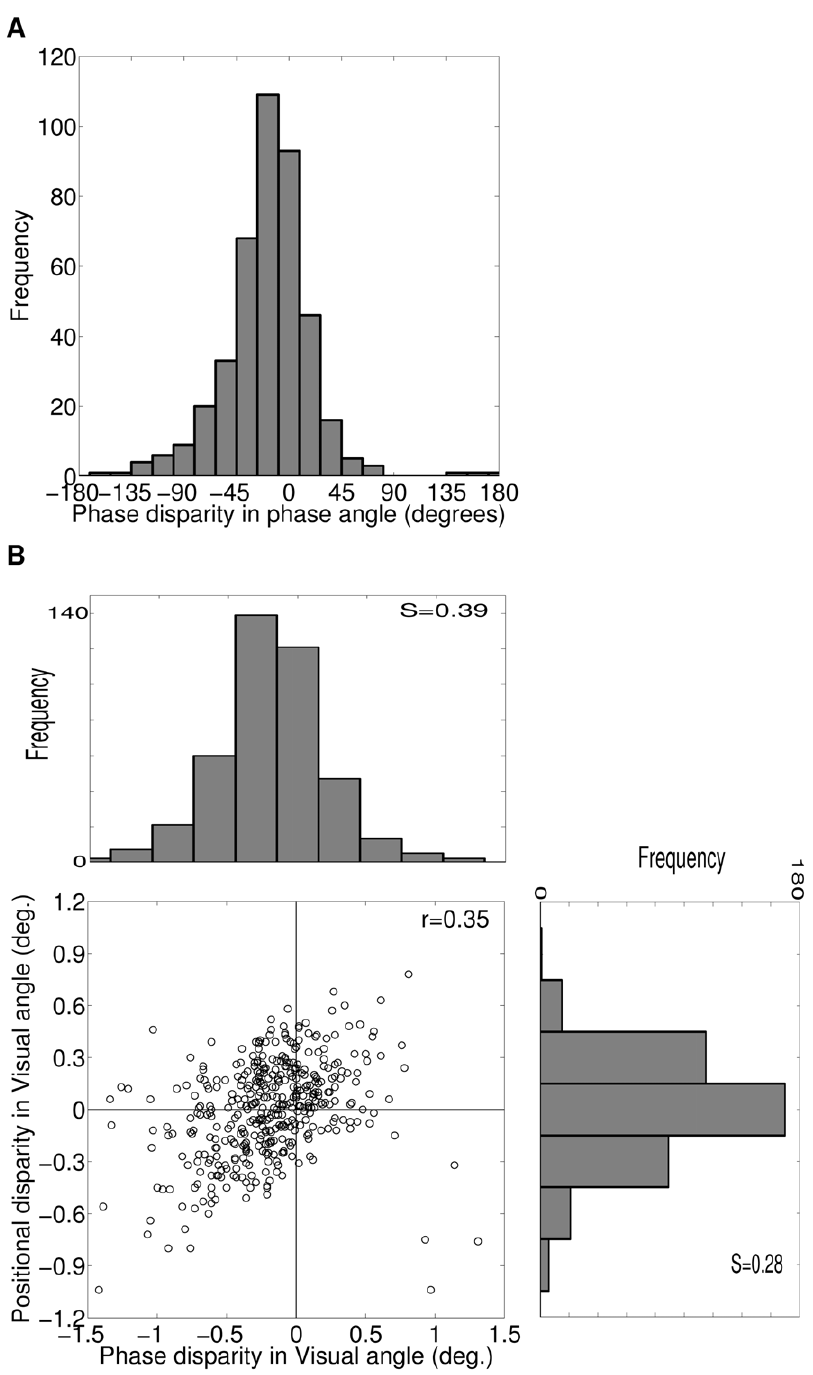
Figure 5. RF phase and positional disparities for 415 cells. (A) Histogram of RF phase disparity in PA. 25% of cells have phase disparities in the range 2 10 u to 10 u PA. Rest 75 u cells have broader range of phase disparities. Overall 95.7% of cells has phase disparity in the range 2 90 u to 90 u PA. The phase disparities lies in the range of 2 162 u to 180 u PA. (B) Scatter plot of RF position disparity versus phase disparity in VA and their respective histograms. The RF position and phase disparities show slight positive correlation between them (r=0.35). The total range of phase disparities lie within 6 1.4 u VA (S=0.39). Total range of position disparities lie within 6 1 u VA (S=0.28). doi:10.1371/journal.pone.0024997.g005 oriented at cell’s binocular preferred OR. The OD peak points are from Figure 7A that the OD peak points appear on/near the marked with white color circle markers. The pinwheel singularities pinwheel singularities, conforming to the experimental finding by are marked with: (i) white colored up pointing triangle markers for Crair et al. [43]. Figure 7B shows the histogram of OD peak points positive pinwheel singularities and (ii) white colored down pointing to pinwheel singularities separation. The mean separation is 2.2 triangle markers for negative pinwheel singularities. It is evident units and median separation is 2 units.